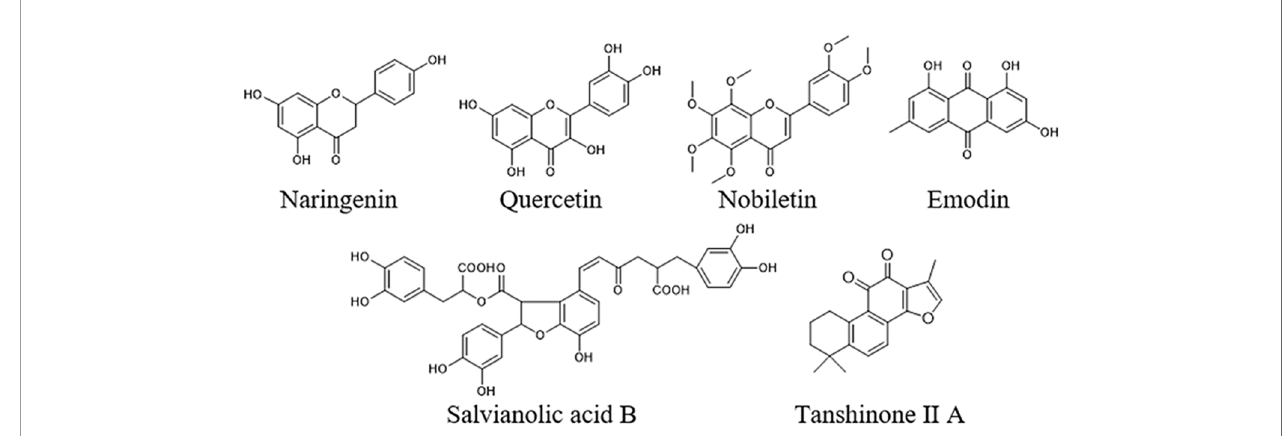
FIGURE 5 | Chemical structures of the six active compounds in DHG including naringenin, nobiletin quercetin, emodin, salvianolic acid B, and tanshinone II A.